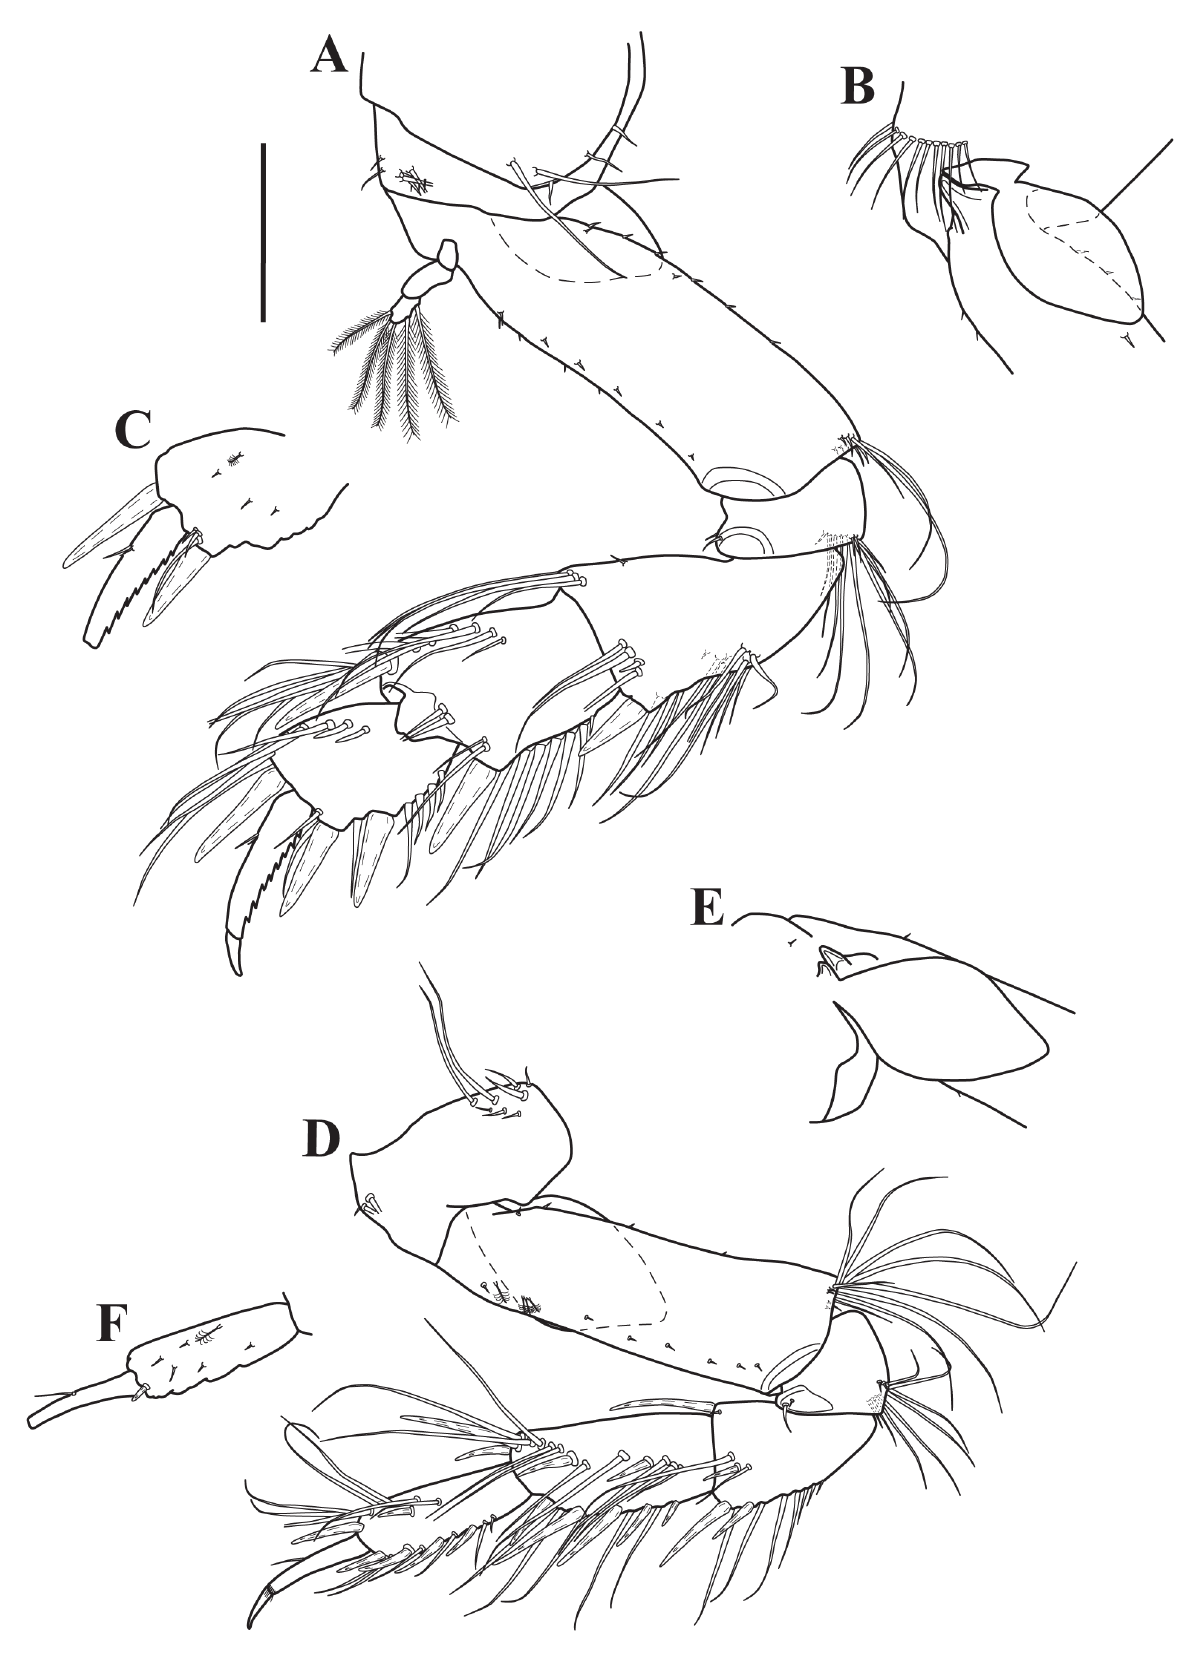
Figure 7. Brachylicoa lui sp. n. holotype female with oostegites and genital cone. A pereopod-1, lateral view; B basis of pereopod-1, inner view; C propodus and dactylus of pereopod-1, inner view; D pereopod-2, lateral view; E basis of pereopod-2, inner view; F propodus and dactylus of pereopod-2, inner view. Scale bar = 0.5